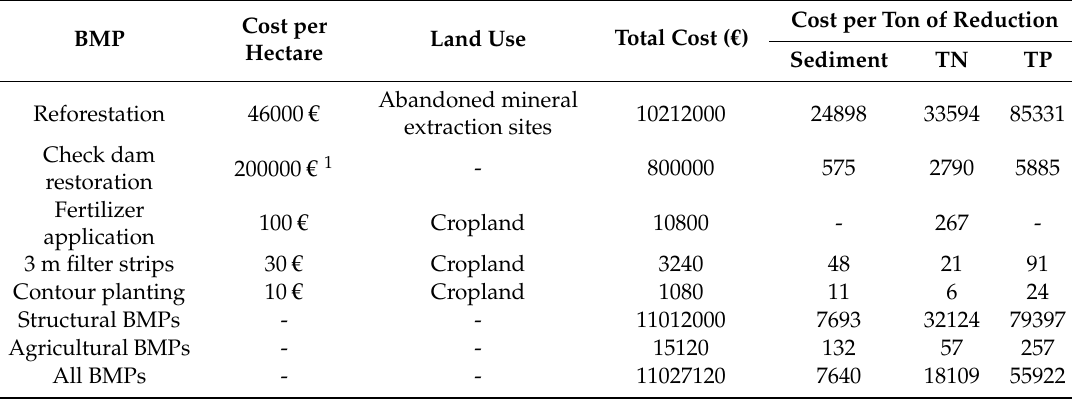
Table 7. Analysis of cost-e ff ective